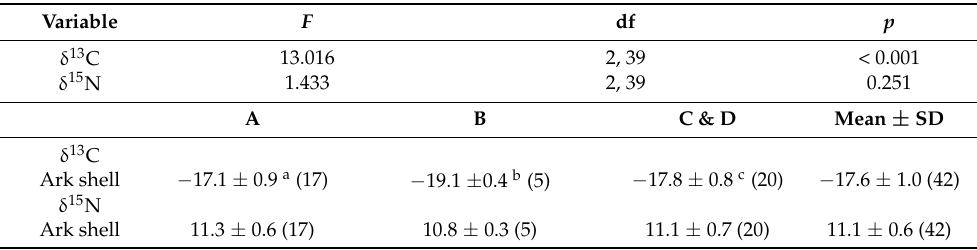
Table 4. δ 13 C and δ 15 N values (‰) of primary consumer, ark shell A. kagoshimensis . The significance of differences in δ 13 C and δ 15 N values among SOM clusters was tested using a one-way analysis of variance (ANOVA) followed by the Tukey post hoc test. Data are the mean ± 1SD and the number of samples ( N ) is in parentheses. The same superscript marked with mean ± 1SD values indicates no significant differences in mean values ( p >